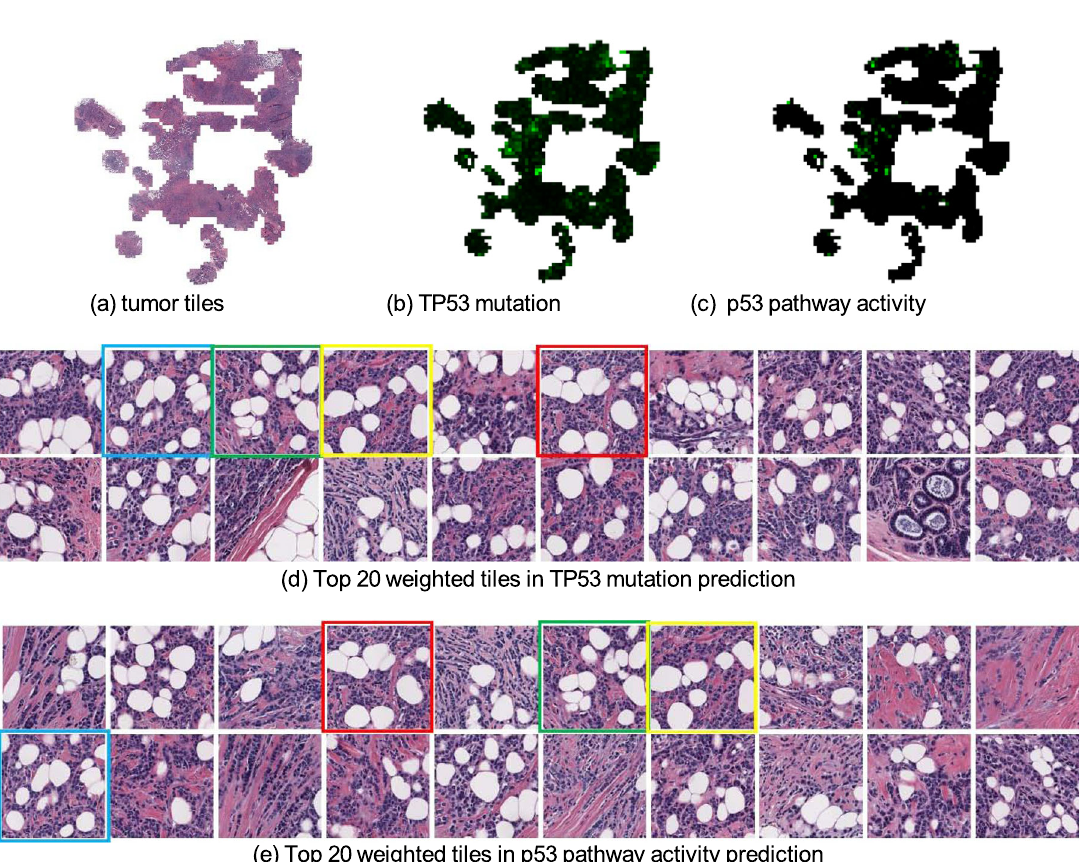
Fig. 3 Weight maps of tiles when predicting the point mutation status of TP53 and p53 pathway activity from mRNA expression data in breast cancer. a Tumor tiles after data processing. b Weight map of tumor tiles in TP53 point mutation prediction. Brighter green tiles have larger weights. c Weight map of p53 pathway activity prediction. d, e Top 20 weighted tiles for TP53 point mutation prediction and p53 pathway prediction, respectively. We marked four tiles that appear in both tasks. These tissues contain poorly differentiated breast carcinoma with small nests, solid sheets, and single cells from a pathologist ’ s